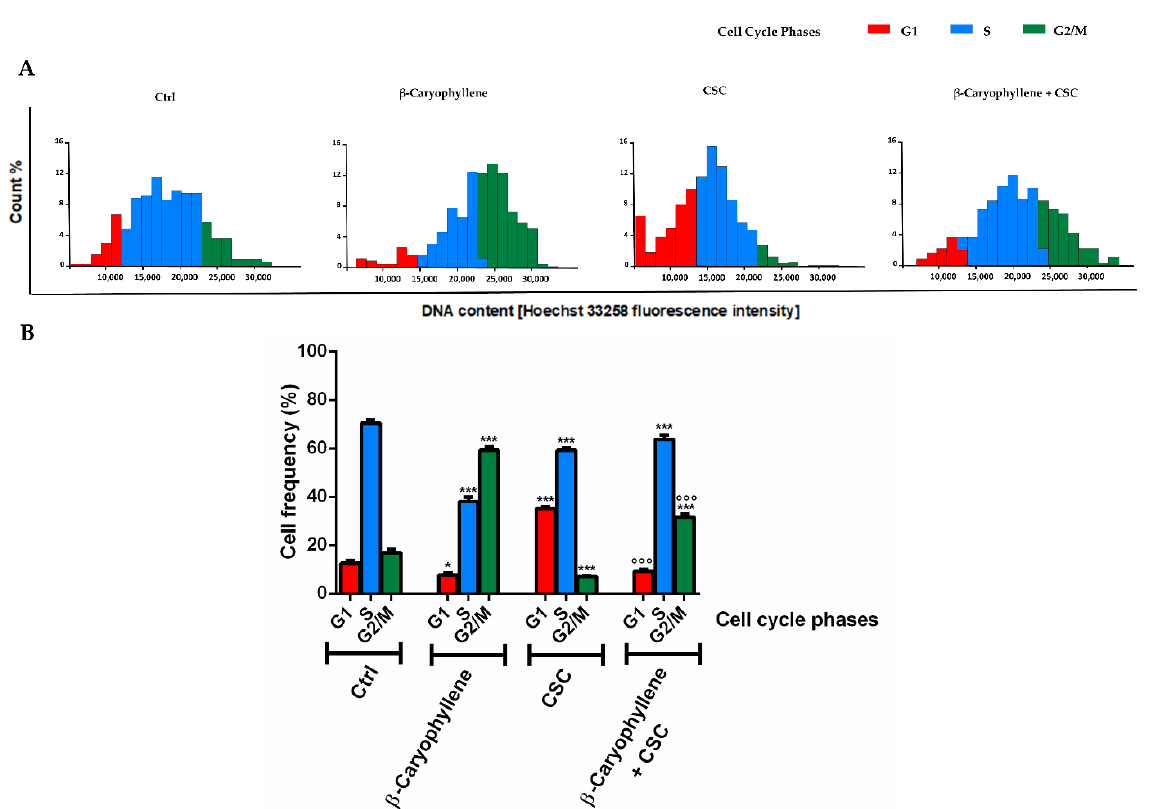
Figure 10. Modulation of cell cycle phases induced by β -caryophyllene and cigarette smoke conden- sate (CSC) in MDA-MB-468 cancer cells after 24 h exposure. ( A ) Histograms showing the percentages of cells stained by Hoechst 33,258 in different cell cycle phases under the scheduled treatments. ( B ) Data are displayed as mean ± SE of at least three independent experiments with at least three technical replicates ( n = 9). * p < 0.05 and *** p < 0.001, significant lowering of cell viability with respect to the control (ANOVA + Dunnett’s multiple comparison post-hoc test). ◦◦◦ p < 0.001, significant difference with respect to CSC (Student’s t -test).